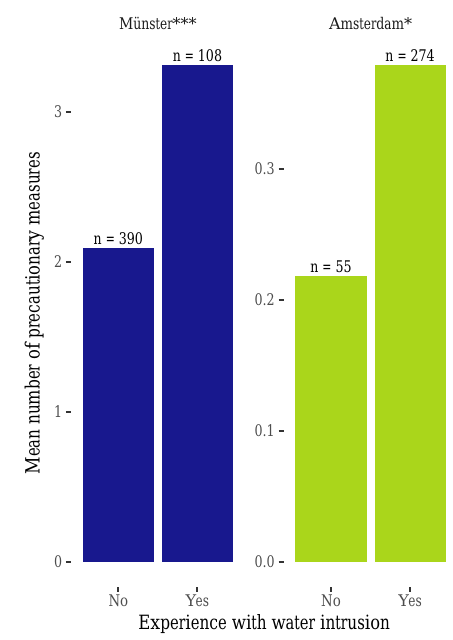
Figure 8. Mean number of precautionary measures against people’s experience with water intrusion. A significant difference, based on two-sided t test, between means is denoted as follows: ∗ = p < 0 . 05, ∗∗ = p < 0 . 01, ∗∗∗ = p < 0 .